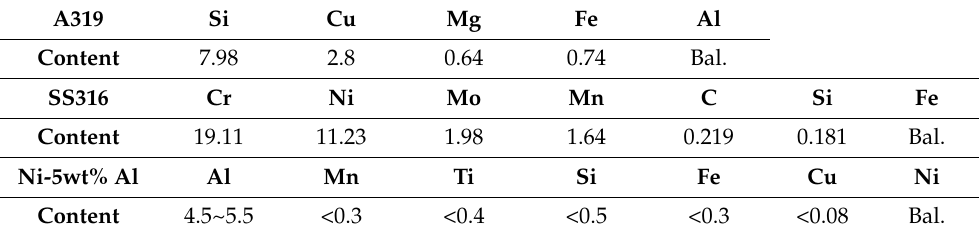
Table 1. Chemical composition of the A319, SS316, and Ni-5wt.% Al alloys (wt.%).